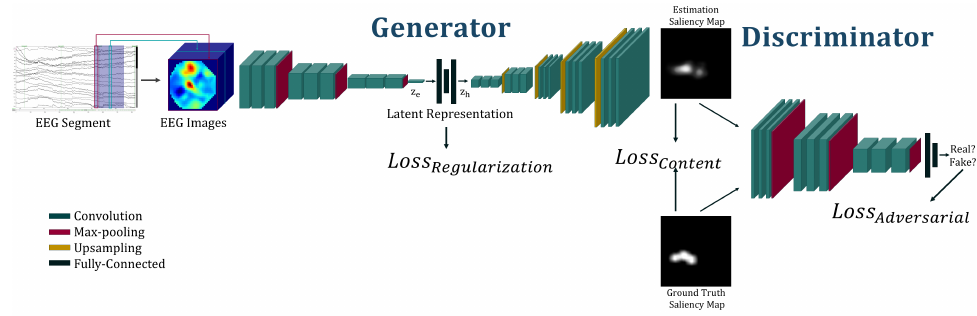
Figure 2. Overview of the architecture composed of the generator and discriminator model. As seen in the figure, the different key steps are represented from left to the right: creation of 3D images from raw EEG signals; encoding of EEG Images into latent representation z e ; distribution mapping from EEG latent representation z e to visual saliency map latent-space representation z h ; decoding to estimate saliency map y p ; discrimination between estimated y p and ground truth saliency map y t